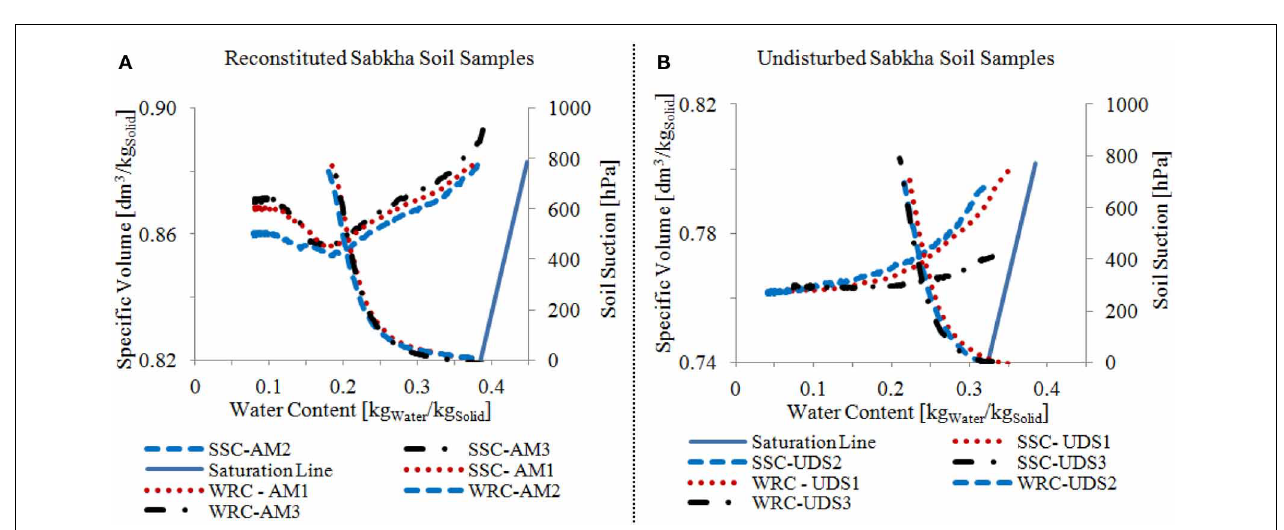
FIGURE 7 | The measured soil moisture characteristic curves for Sabkha soil: Water Retention Curve [WRC] and Soil Shrinkage Curve [SSC] for (A) the three replicates of reconstituted Sabkha soil samples (aggregate size: 200 μ m–2mm); (B) the three replicates of undisturbed Sabkha soil samples.